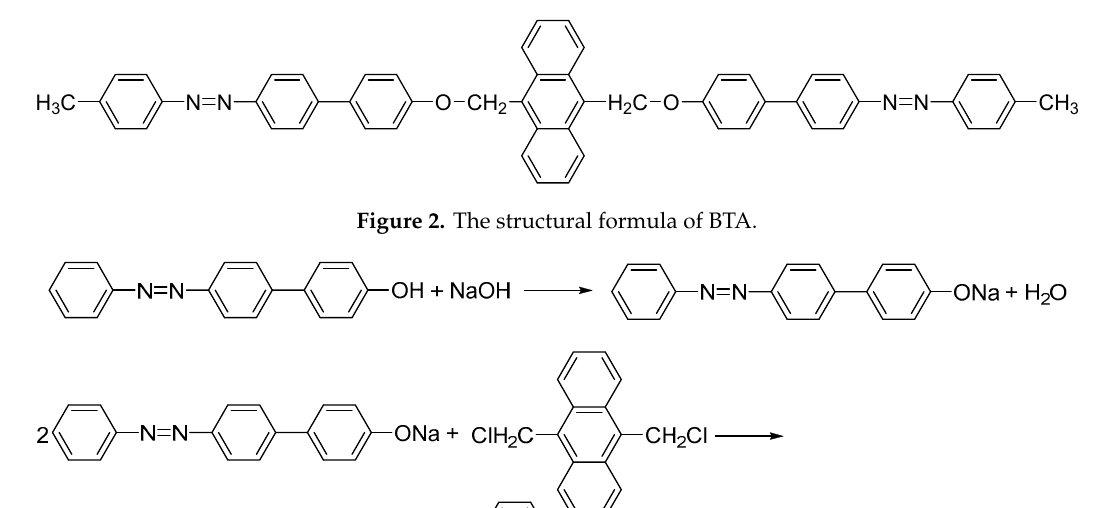
Figure 1. The structural formula of BPA.